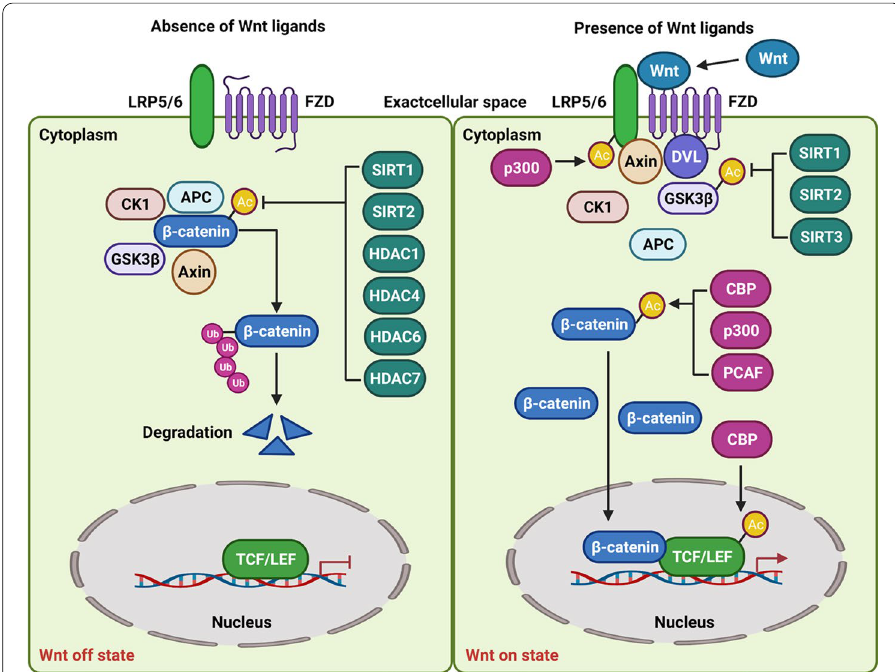
Fig. 1 Regulation of non-histone acetylation on canonical Wnt/β-catenin signaling. Without the binding of Wnt molecules to the FZD-LRP5/6 co-receptor complex, the signaling is inactive (Wnt off state). During the Wnt off state, the destruction complex composed of GSK3β, APC, Axin1, and CK1, can interact with β-catenin, leading to its degradation with ubiquitin–proteasome in the cytoplasm. When Wnt molecules interact with the FZD-LRP5/6 co-receptor (Wnt on state), the complex recruits Axin and DVL to induce the release of β-catenin from the destruction complex and enhance its accumulation as well as nuclear translocation. In the cell nucleus, β-catenin interacts with LEF/TCF and further activates Wnt-dependent gene transcription. During the Wnt off state, acetylation of β-catenin can be inhibited by SIRT1, SIRT2, HDAC1, HDAC2, HDAC4, HDAC6, and HDAC67 to block its activity. During the Wnt on state, LRP6 is acetylated by p300 to facilitate signaling activation. Then, β-catenin is capable of being acetylated by CBP, p300, and PCAF to increase protein activity. Also, acetylation of GSK3β is suppressed by SIRT1, SIRT2, and SIRT3. TCF is acetylated by